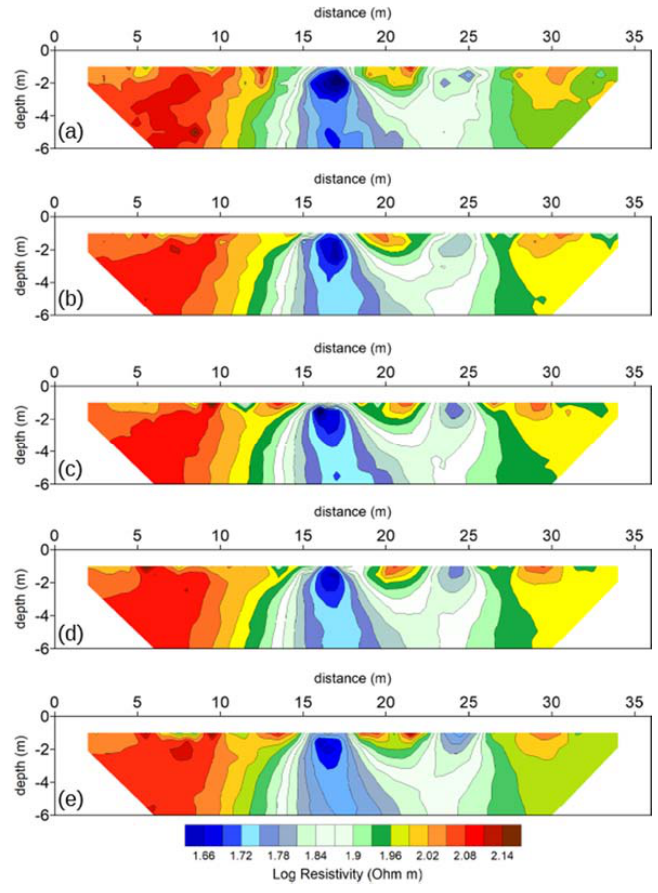
Figure 3. Average sections, obtained by averaging point by point 20 PERTI sections elaborated using randomly extracted N q data (tests) from the N = 295 starting dataset. N q = 50 ( a ), N q = 100 ( b ), N q = 150 ( c ), N q = 200 ( d ) and N q = 250 ( e ).